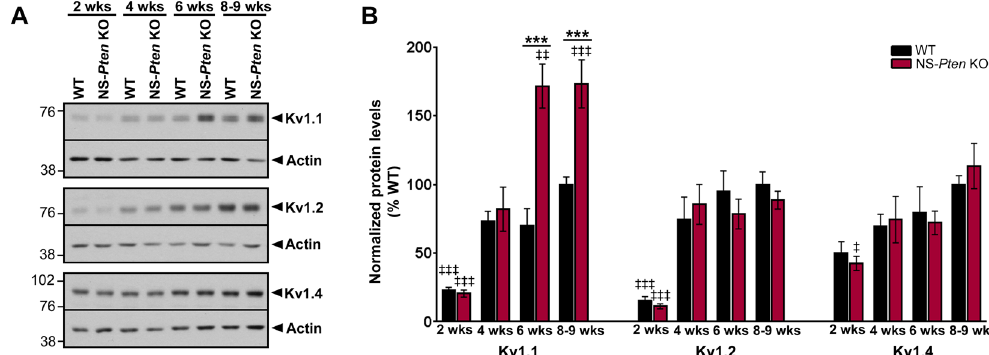
Figure 3. Aberrant increases in hippocampal Kv1.1 protein levels are present in young adult but not juvenile NS- Pten KO mice. ( A ) Representative western blots from whole hippocampal homogenates from 2, 4, 6 and 8–9 week-old WT and NS- Pten KO mice probed with antibodies against Kv1.1, Kv1.2, Kv1.4, and actin are shown. Full-length blots are presented in Supplemental Fig. 2. ( B ) Quantification of western blots showed that Kv1.1 protein levels were not different between age-matched WT and NS- Pten KO and mice at postnatal weeks 2 and 4 (juvenile), but were significantly higher in NS- Pten KO compared to WT mice at postnatal weeks 6 and 8–9 (young adults). Additionally, both WT and NS- Pten KO mice displayed significantly lower Kv1.1 protein levels at postnatal week 2 compared to adult WT mice at postnatal weeks 8–9. Kv1.2 and Kv1.4 protein levels were not different between age-matched WT and NS- Pten KO mice at any time points between postnatal weeks 2 and 8–9. However, both WT and NS- Pten KO mice displayed significantly lower Kv1.2 protein levels at postnatal week 2 compared to adult WT mice at postnatal weeks 8–9. n = 6–15 mice per group; *** p < 0.001 (compared to age-matched WT), ‡ p < 0.05, ‡‡ p < 0.01, ‡‡‡ p < 0.001 (compared to 8–9 week-old WT) by two-way ANOVA with Tukey’s post hoc test; errors bars are ±